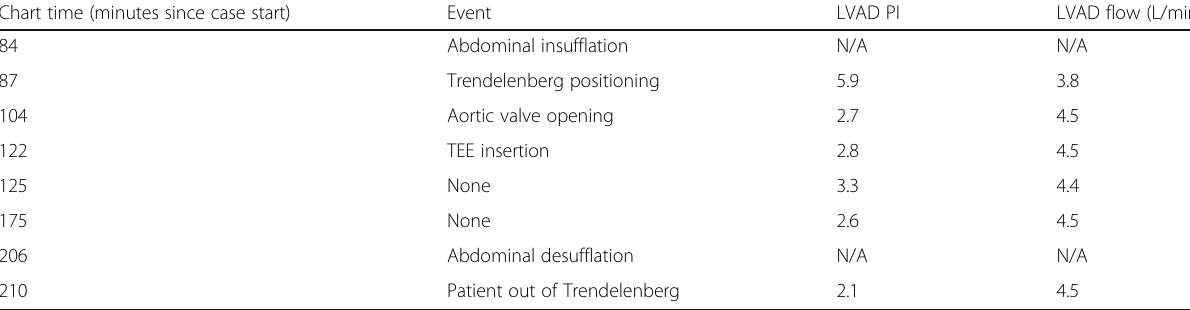
Table 1 Hemodynamic parameters and patient positioning changes Chart time (minutes since case